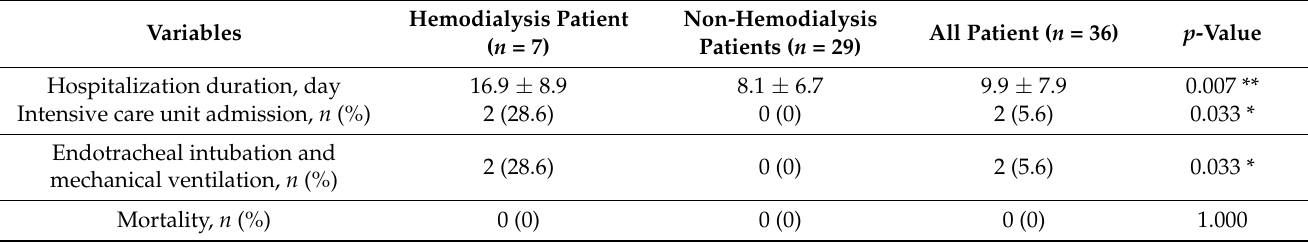
Table 6. Outcomes of patients with lithium poisoning, stratified according to whether they were treated with hemodialysis or not ( n =